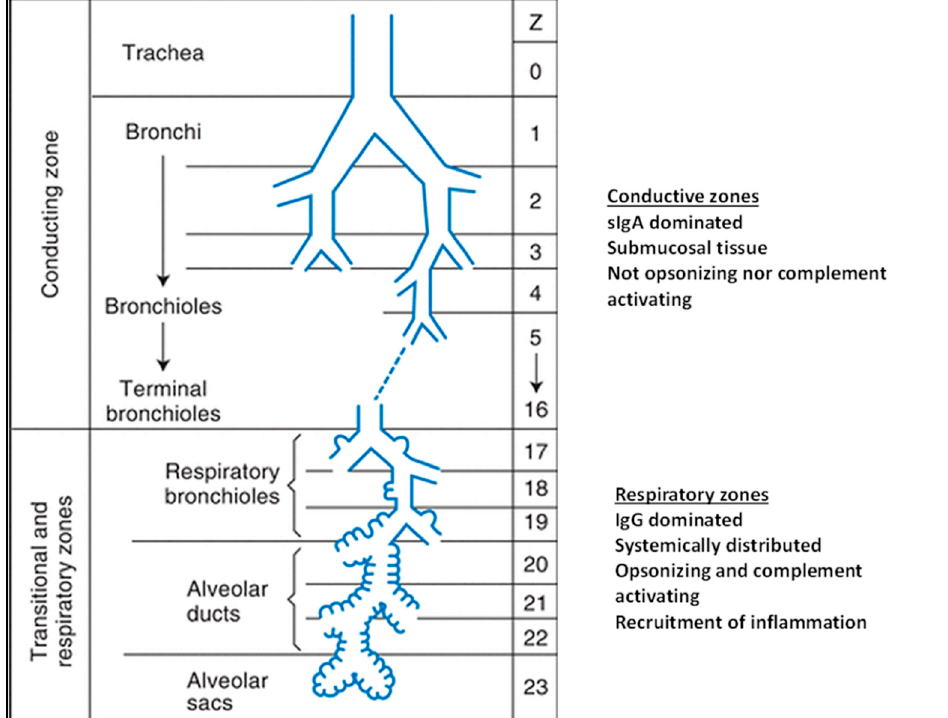
Figure 1. Illustration of the dichotomously branching of the airway from the conducting to the transitional and respiratory airway zones. The functions as well as the localized immune response of the conducting and respiratory zones differ. Numbers indicate approximate airway passages following generational branching (reproduced with permission from Ref. [2]. Copyright 2021 Wolters Kluwer. The conductive airways are a member of the mucosal associated lymphoid tissues (MALT), whereas the respiratory zones are associated to the systemic immune